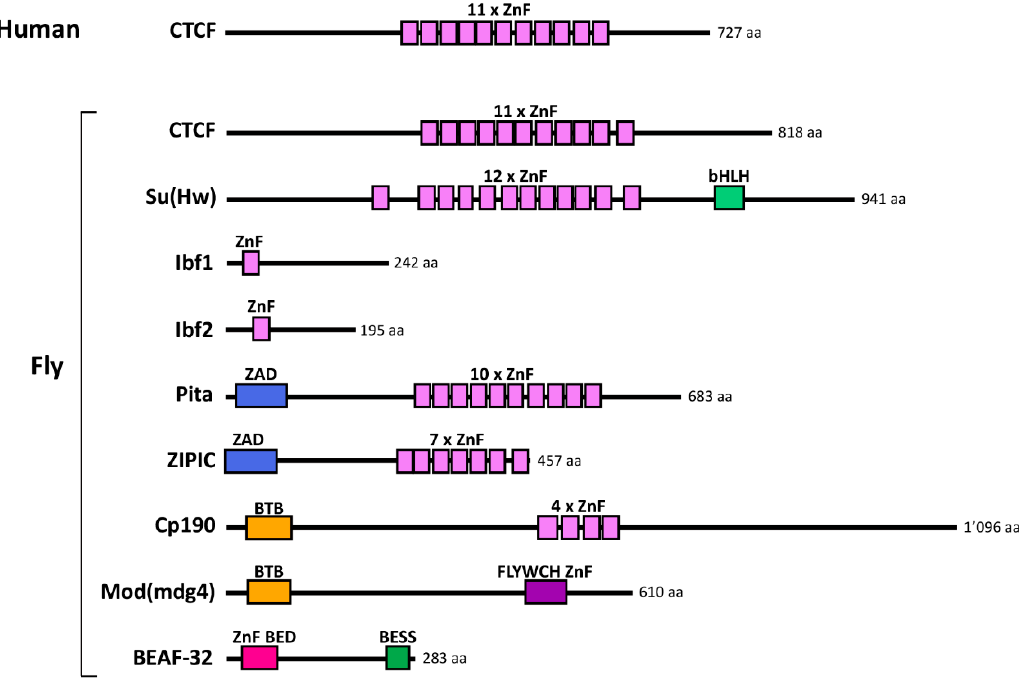
Figure 2. Examples of known insulator-binding proteins (IBPs) in humans and flies. Schematics of the protein domain organization of IBPs are drawn to scale. Abbreviations are as follows: CTCF: CCCTC-binding factor; Su(Hw): Suppressor of Hairy wing; Ibf: Insulator binding factor; ZIPIC: Zinc-finger protein interacting with Cp190; Cp190: Centrosomal protein 190 kDa; Mod(mdg4): modifier of mdg4; BEAF-32: Boundary element-associated factor of 32 kDa; ZnF: zinc finger; ZAD: zinc finger associated domain; BTB: Broad-Complex, Tramtrack and Bric-a-brac; bHLH: basic helix-loop-helix; BED: BEAF-32 and DREF; BESS: BEAF-32, Suvar(3)7 and Stonewall.